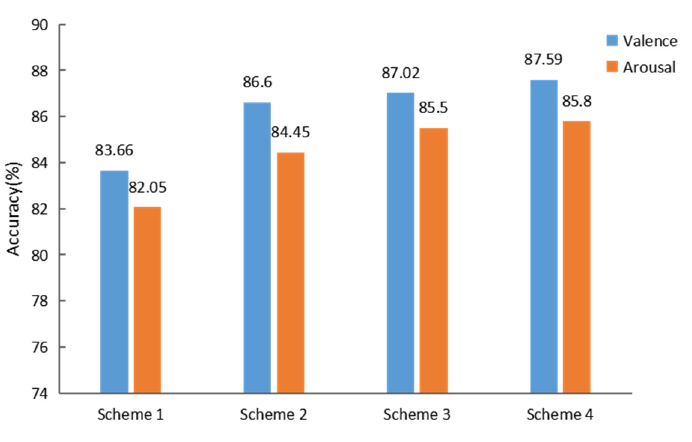
Figure 7. Performance comparison of models with different numbers of convolution kernels.